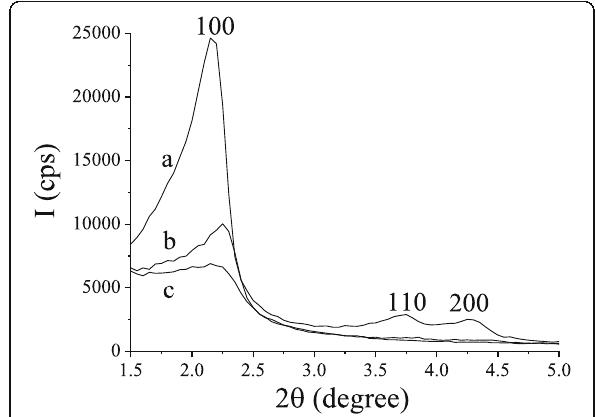
Fig. 2 XRD patterns of β -CD-APTES-MCM-41 ( a ), β -CD-APTES 3 -MCM- 41 ( b ), and β -CD-APTES 5 -MCM-41 ( c )